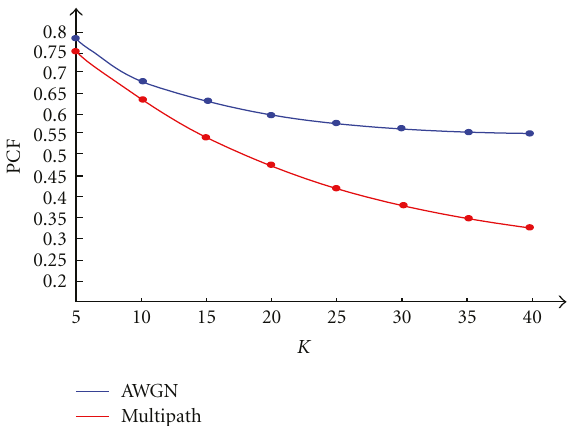
Figure 8: Optimal PCF versus the number of users: the AWGN and multipath